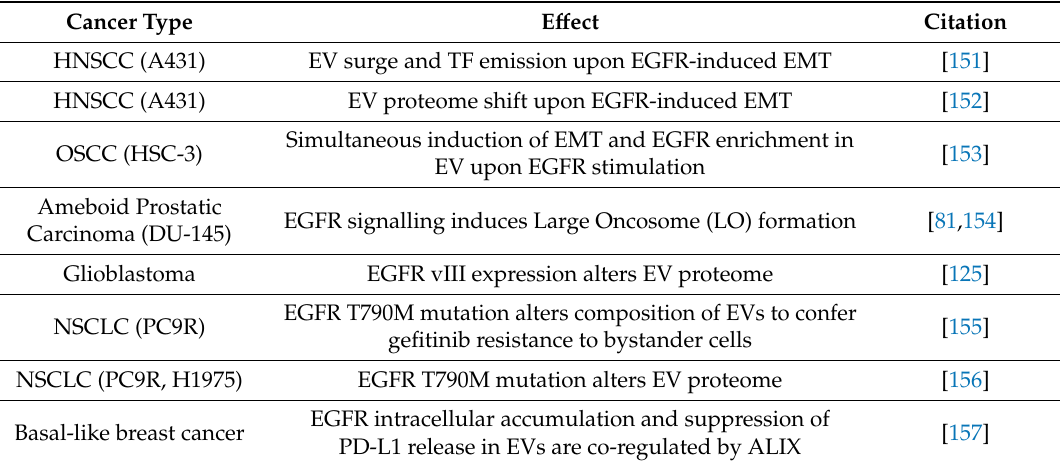
Table 1. Evidence for EGFR-mediated EV biogenesis in